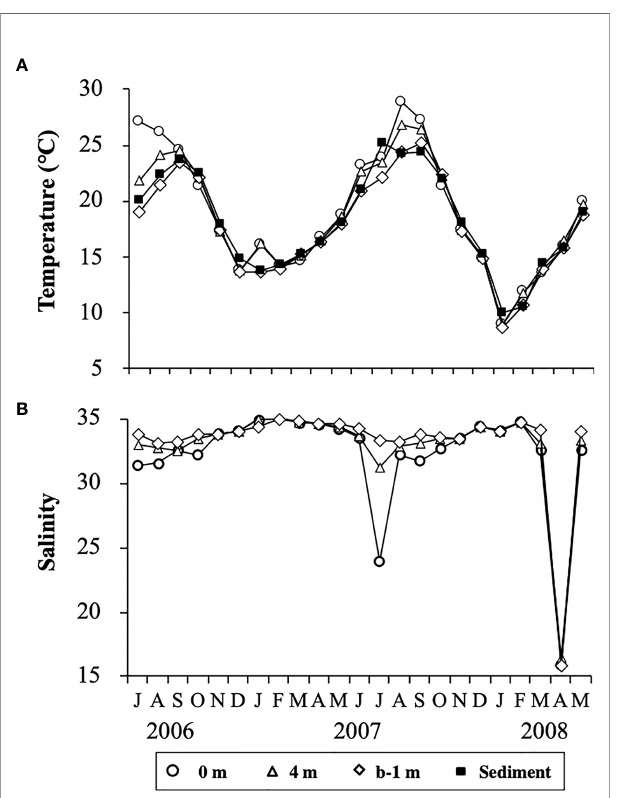
FIGURE 4 | Temporal changes in temperature (A) at different depths in the water column and at 1 cm depth in the sediment, and salinity (B) at different depths in the water column at the sampling site in Ago Bay. b-1 m denotes the depth at 1 m above the